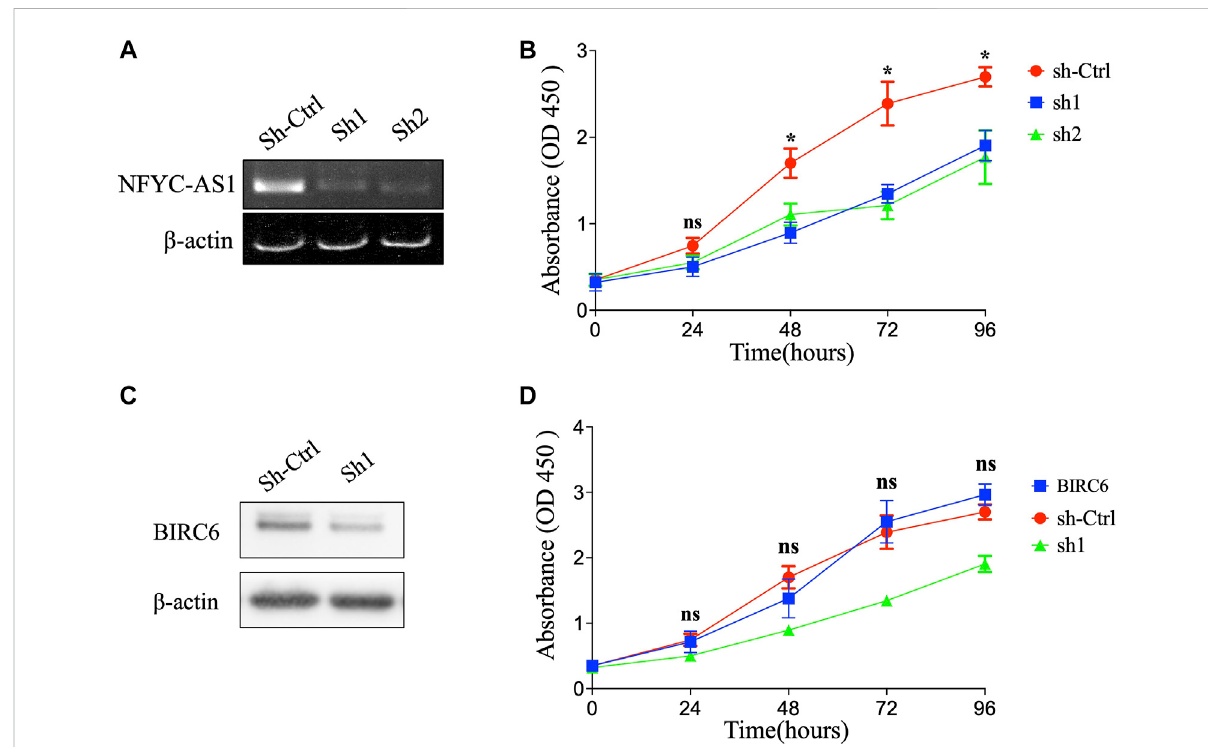
FIGURE 11 The in fl uence of NFYC-AS1 and BIRC6 on the proliferation of LUAD cell lines. (A) RT-PCR results of NFYC-AS1 expression in A549 cells with or without shRNA knockdown. (B) The cell proliferation of A549 cells with or without knockdown of NFYC-AS1 expression. (C) Immunoblot of BIRC6 expression in A549 cells with or without knockdown of NFYC-AS1 expression. (D) The cell proliferation of A549 cells with knockdown of NFYC-AS1 expression or the rescue of BIRC6